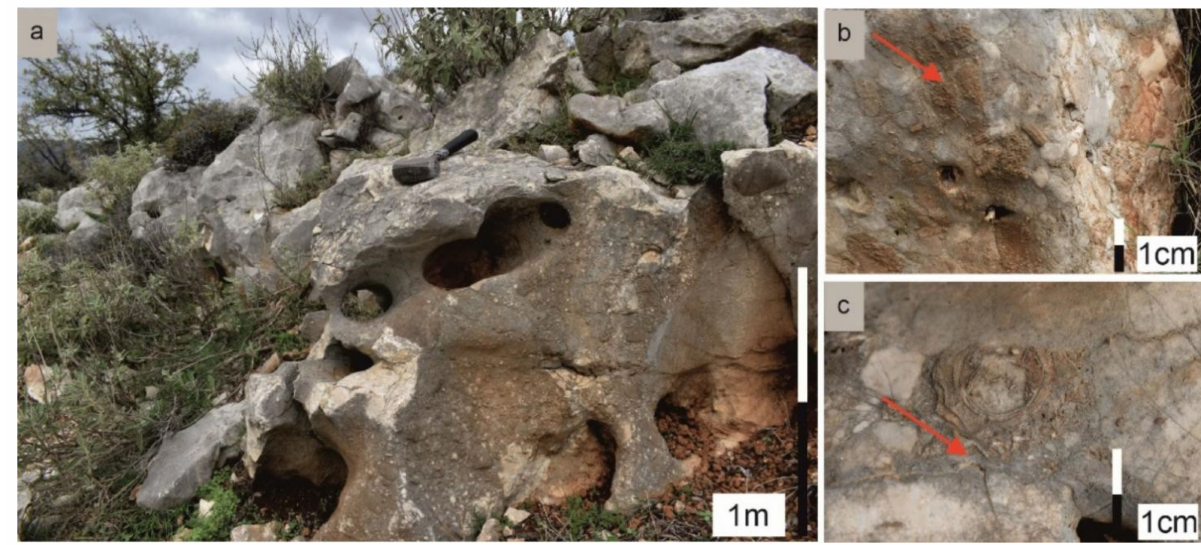
Figure 5. ( a ) General view of the Upper Cretaceous (Maastrichtian) brecciated limestones outcrop with Rudist fragments, ( b , c ) Rudist fragments (red